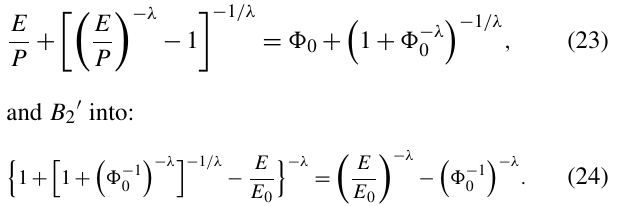
is also worth noting that when α 0 is expressed by Eq. (22) and (cid:56) 0 tends to zero (or (cid:56) − 1 tends to infinite), α w /α 0 in 0 Eqs. (20) and (21) tends to 1. This means that these equations have the same limits as their original equations (Eqs. 4,